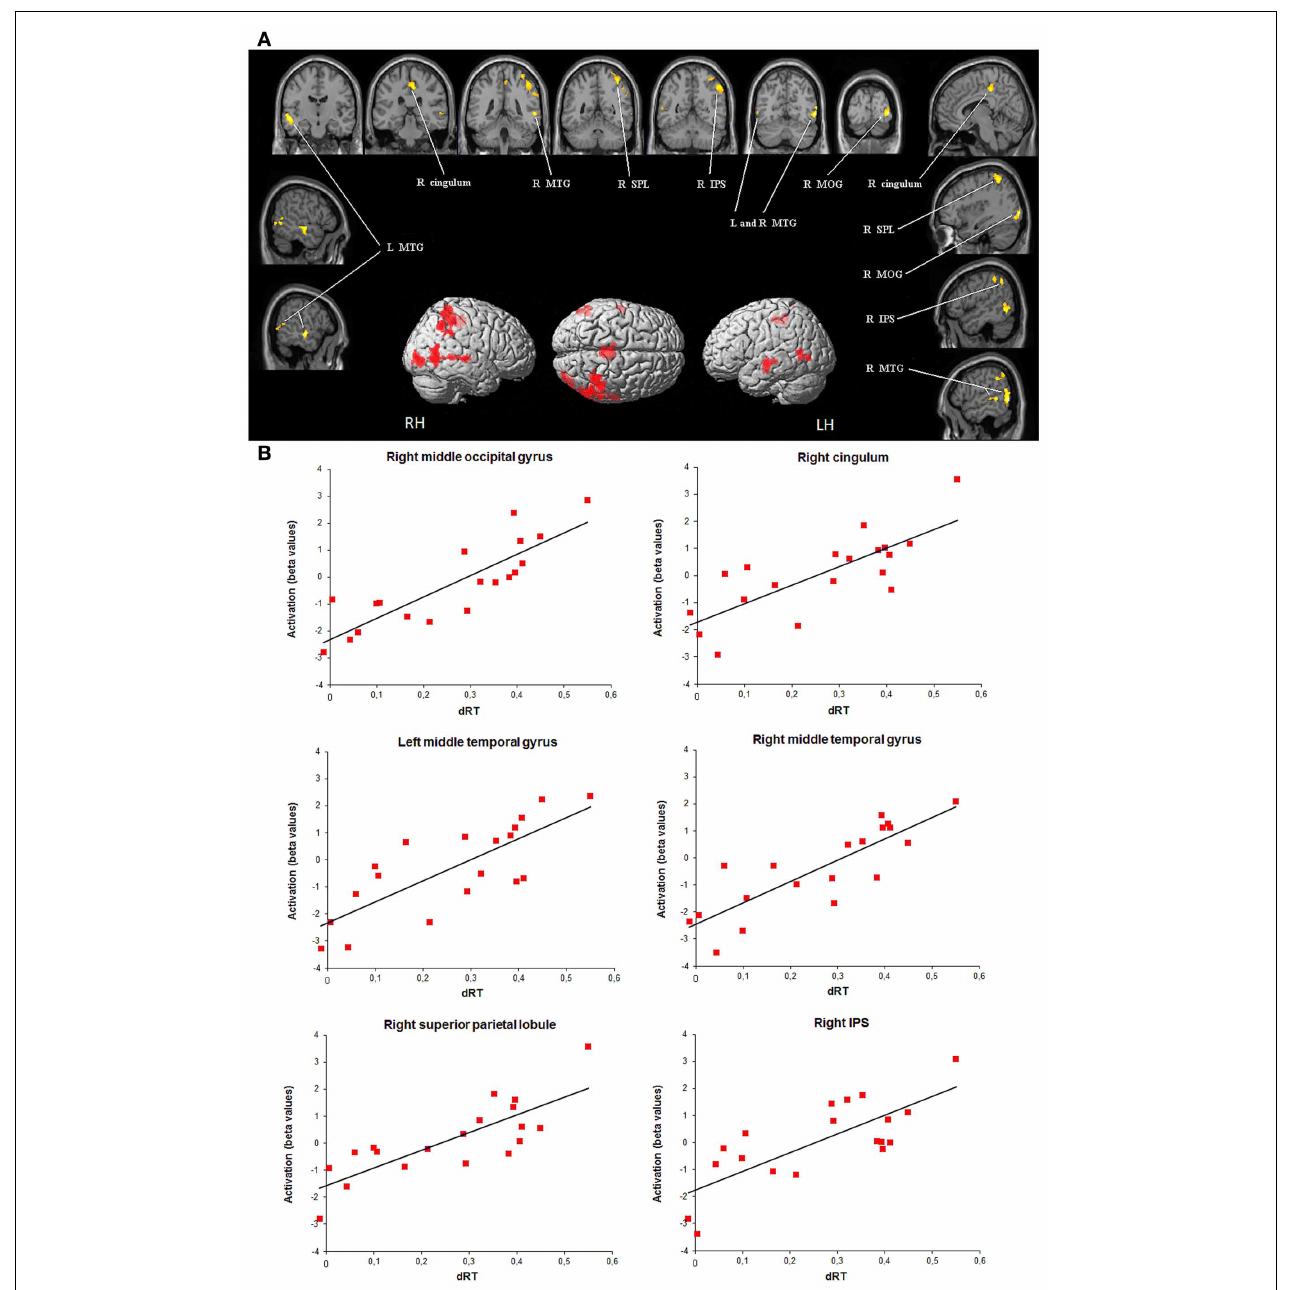
FIGURE 2 | Brain areas that showed significant increases in activation with sensitivity to numerical distance effect (dRT). (A) Brain regions ( P < 0 . 05 corrected for multiple comparisons at the cluster level) are superimposed on sagittal and coronal sections of an individual normalized brain MRI. Surface rendering of significant areas of activation that are positively correlated with dRT scores are superimposed on a standard MRI